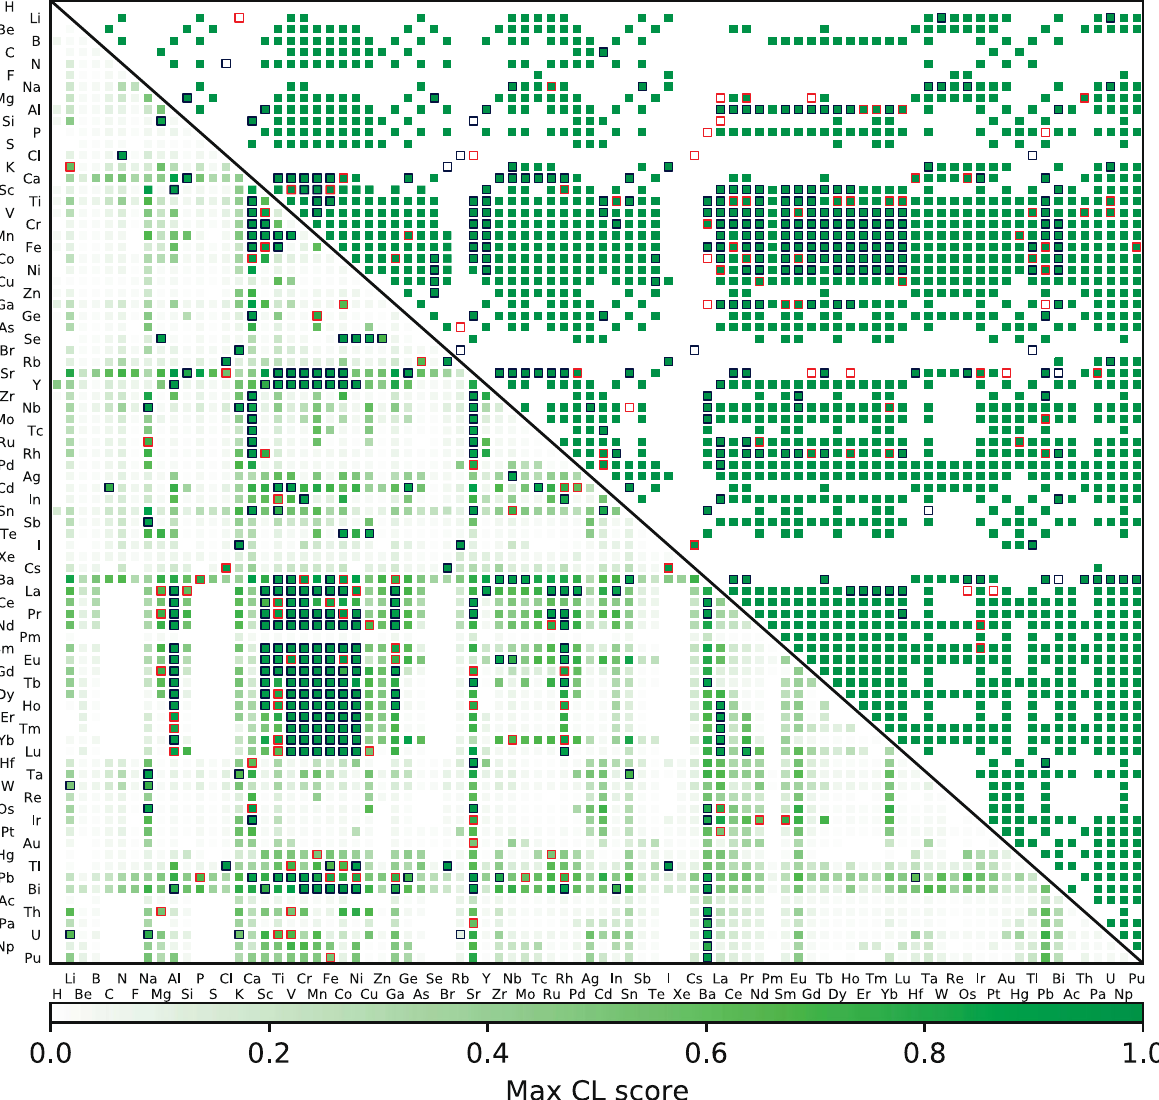
Fig. 4 Synthesizability of the ABO 3 perovskite compounds for our model (lower left triangle) and Goldschmidt-rule-based screening (upper right triangle). The green color in the lower left triangle indicates the maximum CL score for the perovskites structures from the databases with the given compositions, the color bar of which at the bottom of the fi gure, and the green color in the upper right triangle indicates that the combination passes the screening. The blue box indicates that the combination has been synthesized before. The red boxes indicate the virtual crystals that were found synthesized